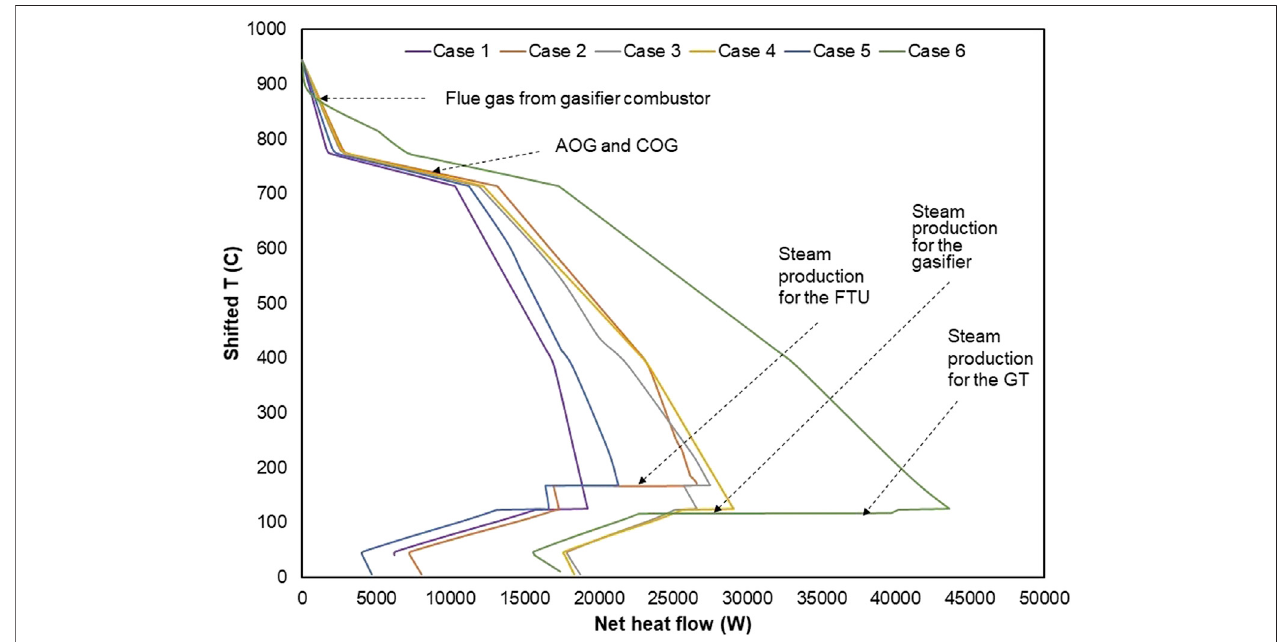
FIGURE 3 | GCCs of Cases 1 to